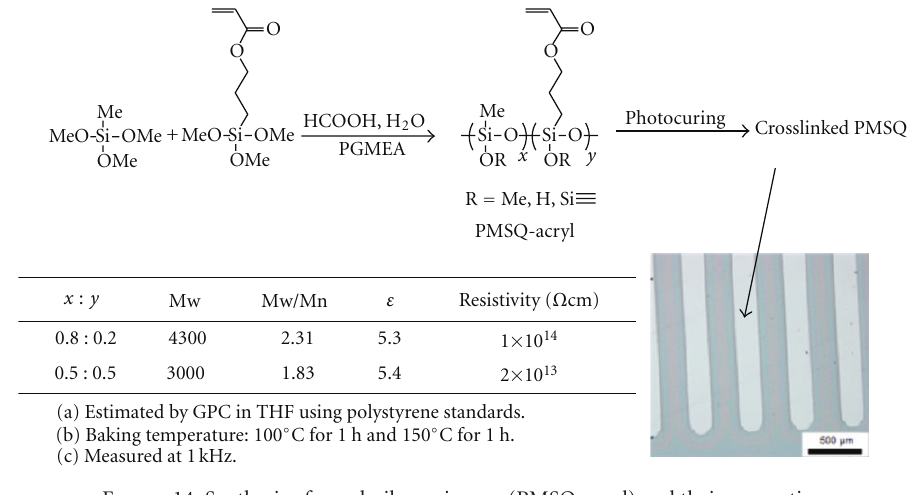
Figure 14: Synthesis of copolysilsesquioxane (PMSQ-acryl) and their